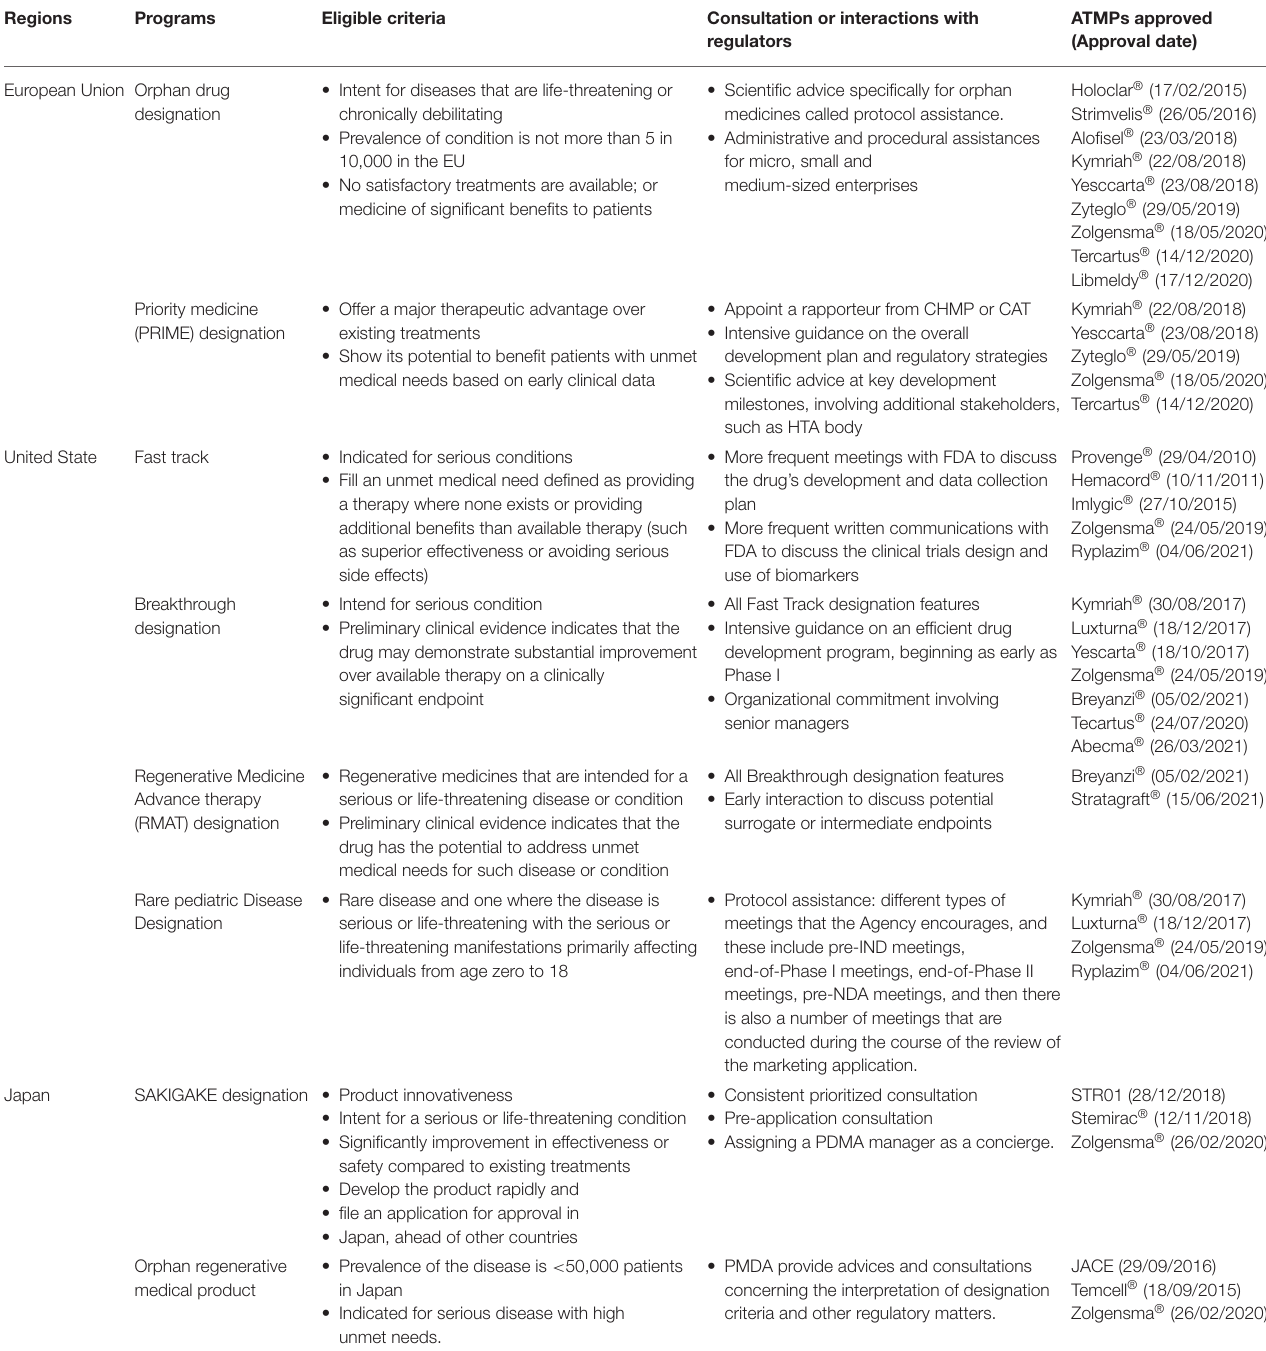
TABLE 4 | Accelerated approval programs allow enhanced interactions between manufacturers and regulators.